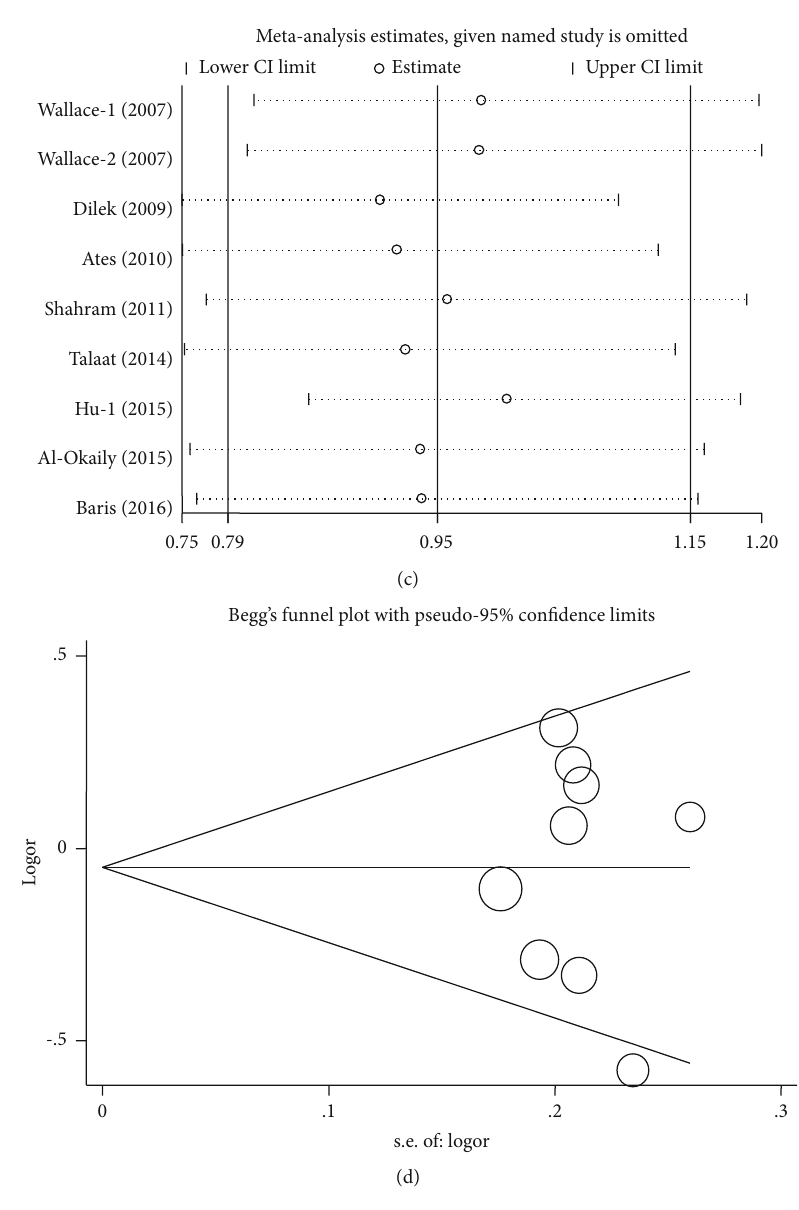
Figure 2: Statistical analysis of the association between IL-10 -1082A > G polymorphism and BD risk in the G vs. A model. (a) ORs and 95% CIs; (b) cumulative analysis; (c) sensitivity analysis; (d) publication